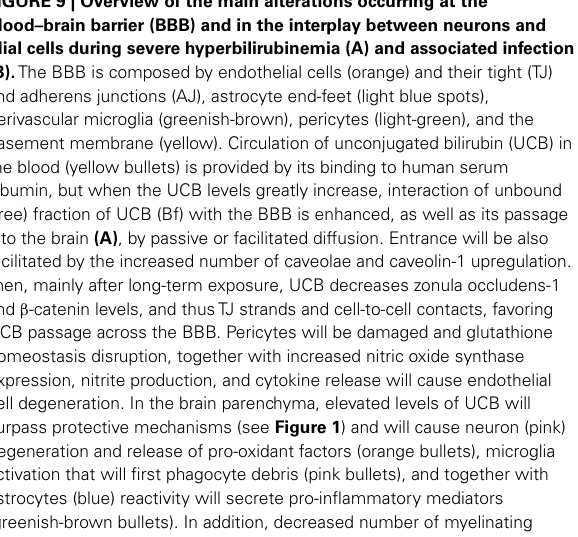
FIGURE 9 | Overview of the main alterations occurring at the blood–brain barrier (BBB) and in the interplay between neurons and glial cells during severe hyperbilirubinemia (A) and associated infection (B). The BBB is composed by endothelial cells (orange) and their tight (TJ) and adherens junctions (AJ), astrocyte end-feet (light blue spots), perivascular microglia (greenish-brown), pericytes (light-green), and the basement membrane (yellow). Circulation of unconjugated bilirubin (UCB) in the blood (yellow bullets) is provided by its binding to human serum albumin, but when the UCB levels greatly increase, interaction of unbound (free) fraction of UCB (Bf) with the BBB is enhanced, as well as its passage into the brain (A) , by passive or facilitated diffusion. Entrance will be also facilitated by the increased number of caveolae and caveolin-1 upregulation. Then, mainly after long-term exposure, UCB decreases zonula occludens-1 and β -catenin levels, and thusTJ strands and cell-to-cell contacts, favoring UCB passage across the BBB. Pericytes will be damaged and glutathione homeostasis disruption, together with increased nitric oxide synthase expression, nitrite production, and cytokine release will cause endothelial cell degeneration. In the brain parenchyma, elevated levels of UCB will surpass protective mechanisms (see Figure 1 ) and will cause neuron (pink) degeneration and release of pro-oxidant factors (orange bullets), microglia activation that will first phagocyte debris (pink bullets), and together with astrocytes (blue) reactivity will secrete pro-inflammatory mediators (greenish-brown bullets). In addition, decreased number of myelinating